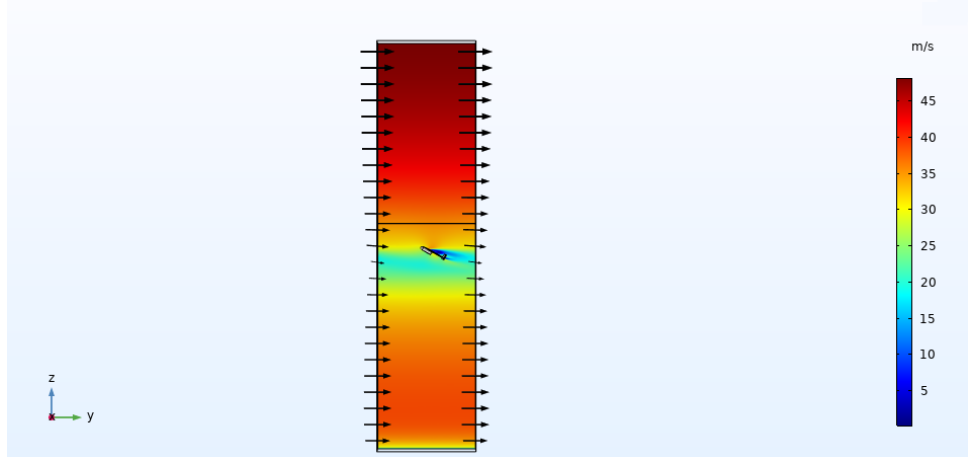
Figure 2. Maximum wind flow in ms − 1 at 2000m of altitude and 30° Angle of Attack (AOA).